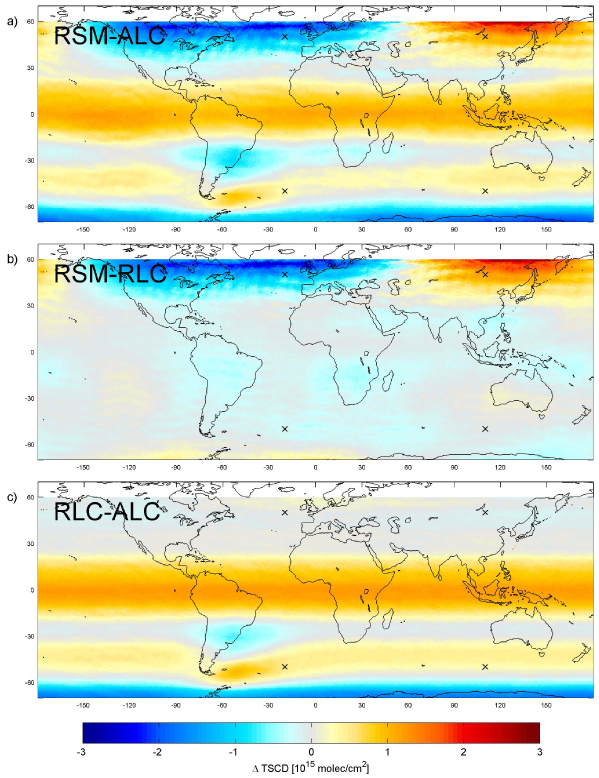
Fig. 7. Mean tropospheric SCDs for January 2003–2008. (a) T RSM : reference sector method. (b) T ALC : absolute limb correction. (c) T RLC : relative limb correction.